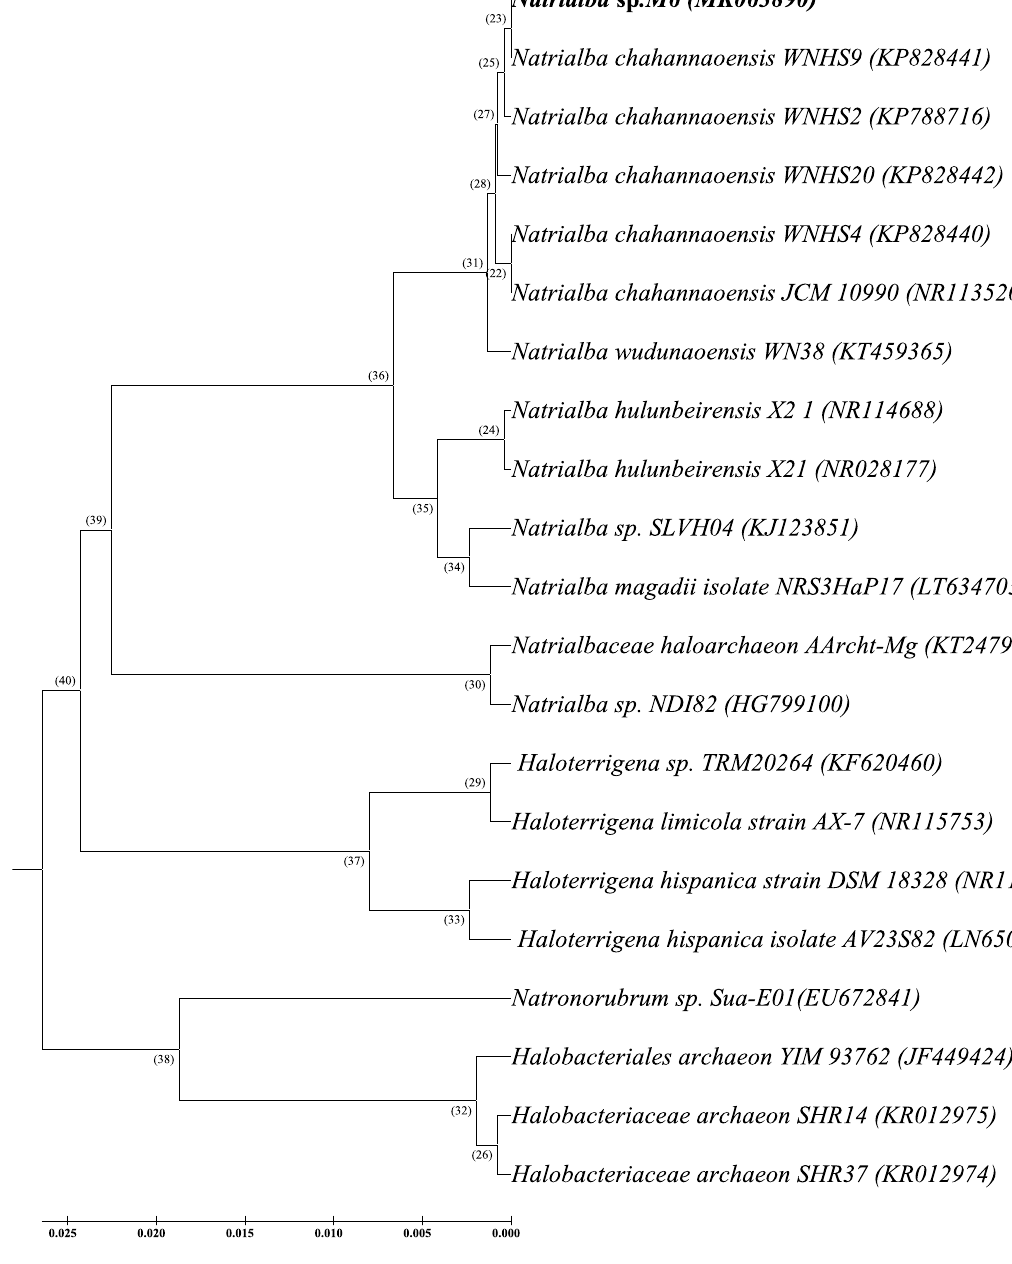
Figure 1. A Phylogenetic tree, based on the 16S rRNA gene sequence comparison showing the position of the haloalkaliphilic archaeal isolate coded M6, from El Hamra Lake, Wadi El Natrun, and its closest